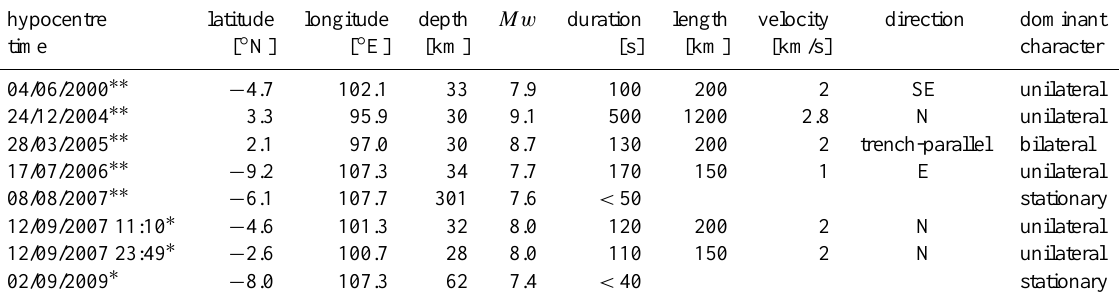
Table 1. Results for selected major earthquakes along the Sunda arc since 2000. Hypocentre parameters and magnitudes are obtained from GEOFON ( ∗ http://geofon.gfz-potsdam.de) or USGS ( ∗∗ http://earthquake.usgs.gov/eqcenter). hypocentre latitude longitude depth Mw duration length velocity direction dominant time [ ◦ N] [ ◦ E] [km] [s] [km] [km/s] character 04/06/2000 ∗∗ − 4.7